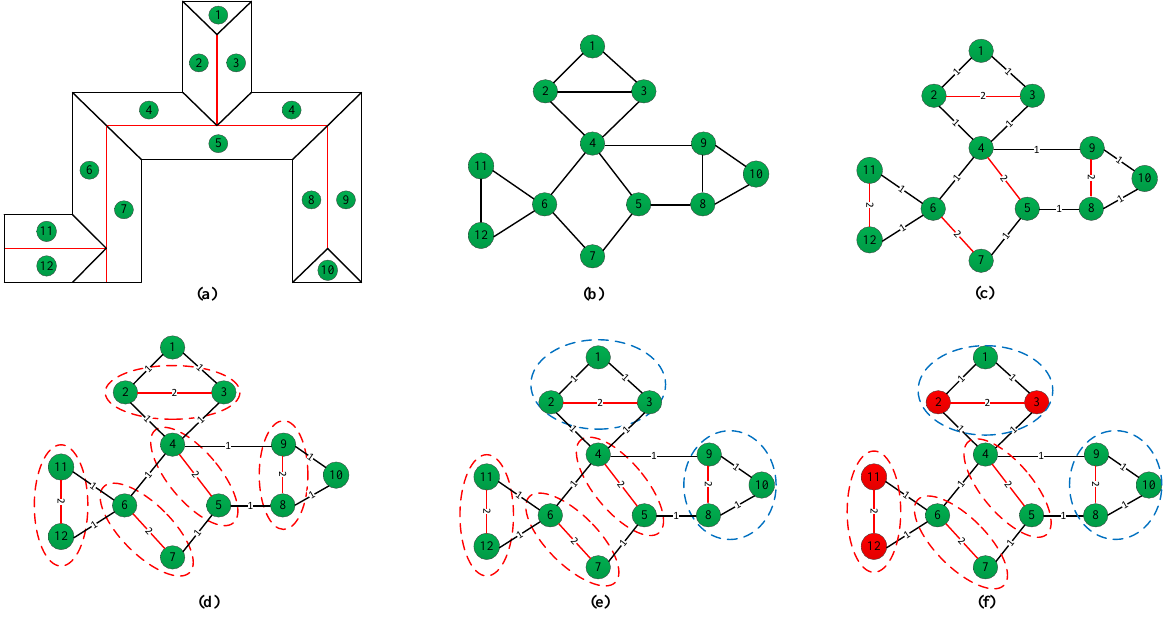
Figure 3. The construction of a compound building’s attributed graph. ( a ) The segmented planar patches of a compound building; ( b ) adjacency graph of the segmented planar patches; ( c ) edge labeling according to the normal vector of two adjacent planar patches; ( d ) extraction of anti-symmetry planar patches; ( e ) grouping of remaining planar patches; and ( f ) attributed graph of a compound